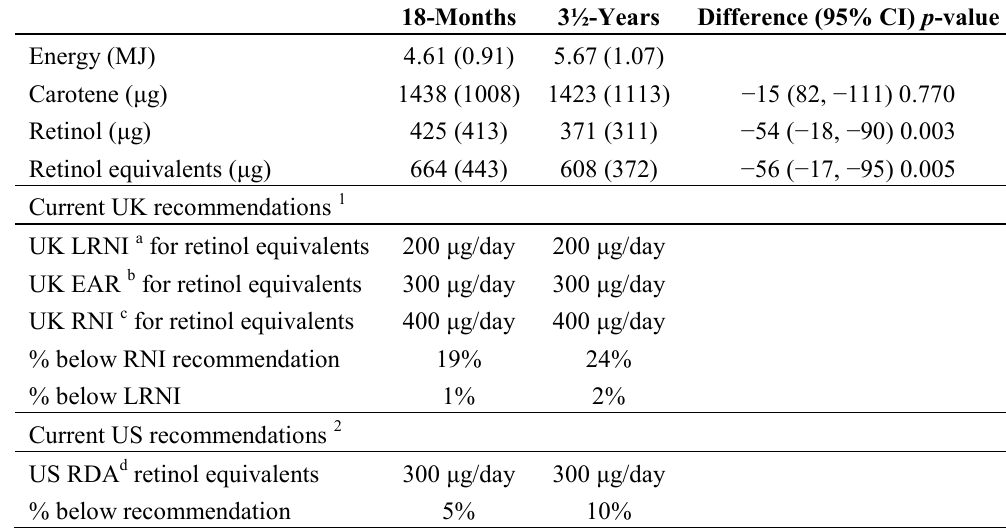
Table 1. Mean (standard deviation) daily energy, carotene, retinol and retinol equivalent intakes in a cohort of children ( n = 755) at 18 months and 3½-years and the proportion of children below target intakes. Change in intake over time, mean difference (95% confidence intervals) and significance by paired t